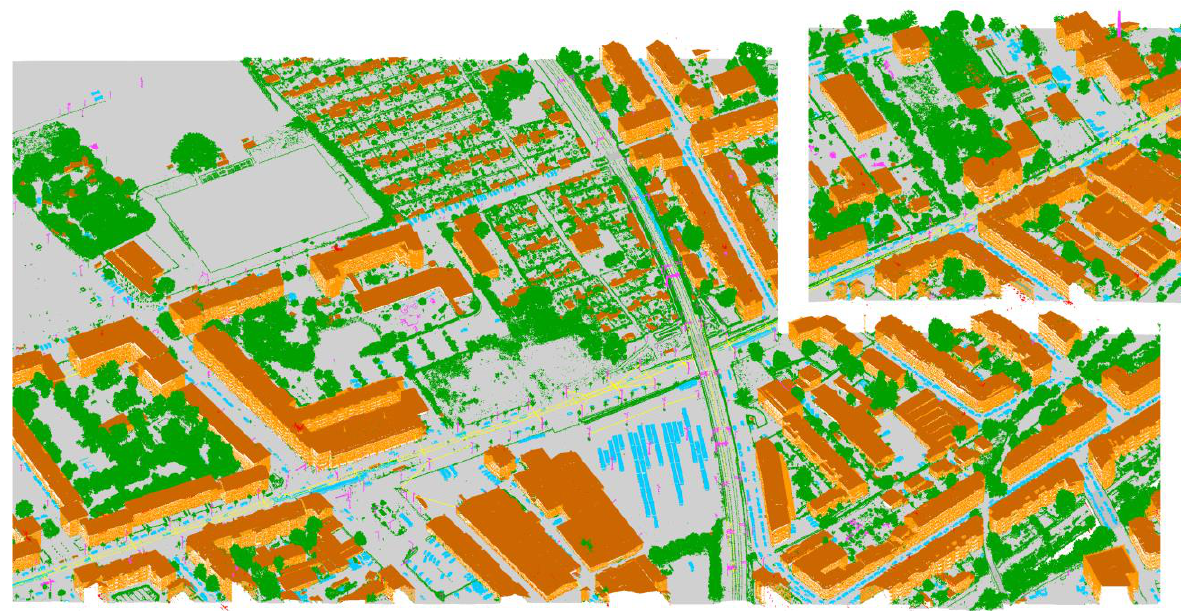
Figure 2 . Training and test data of Leipzig, Germany, with the semantic classes: ground (gray), vegetation(green), building roof (brown), building facade (orange), vehicle (light blue), overhead line (yellow), pole (purple), bridge (dark gray), error and outlier (red). The test tile seamlessly adjoins the training data, but is presented with a horizontal offset for better visualization.